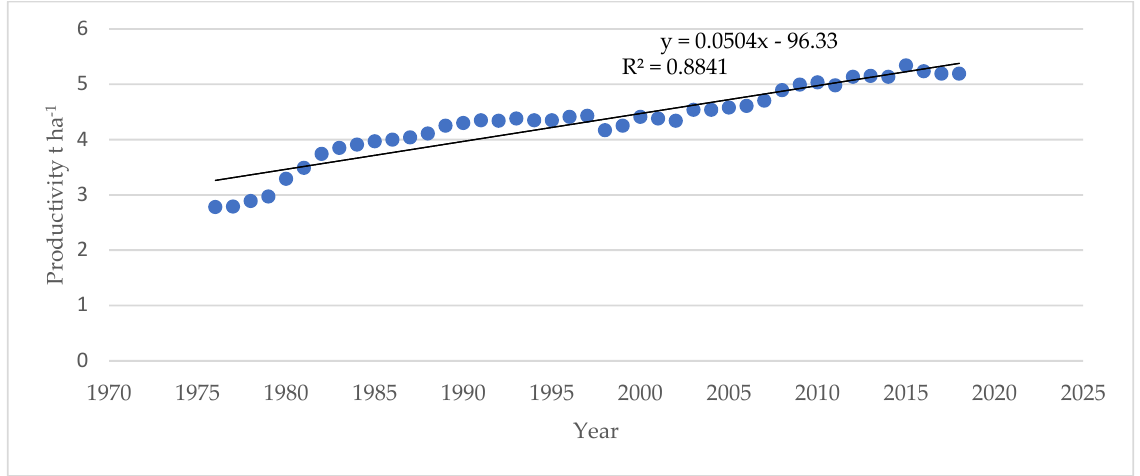
Figure 1. The Indonesian rice production from 1945 to 2016.